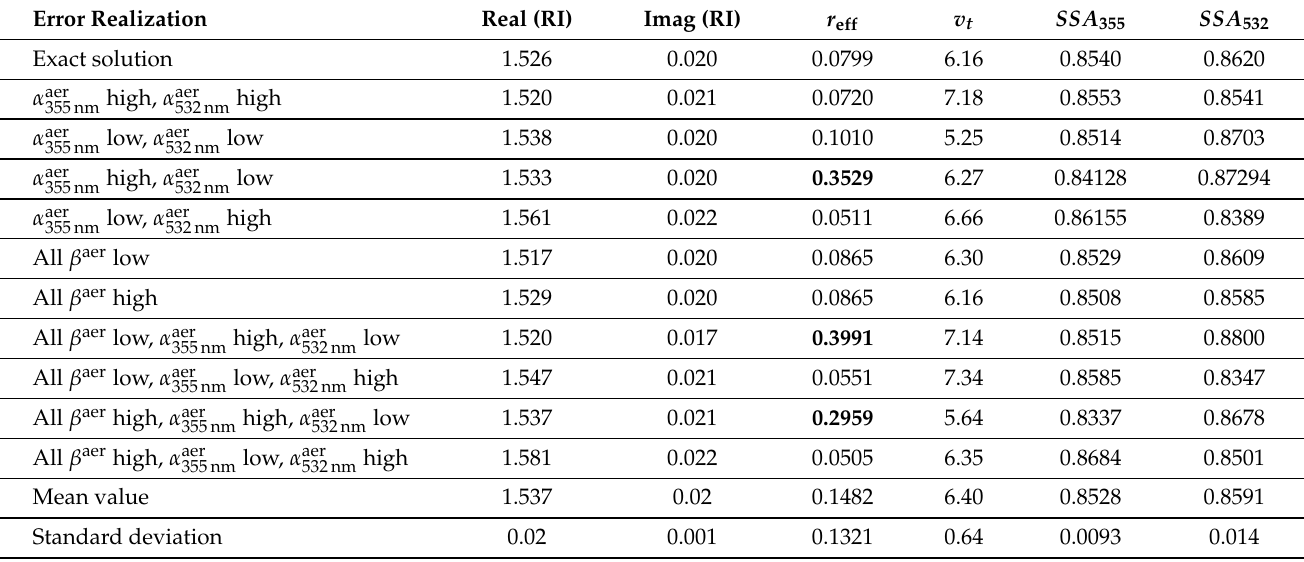
Table A1. Microphysical parameters for the low layer on 21 February 2020, considering errors in the lidar input